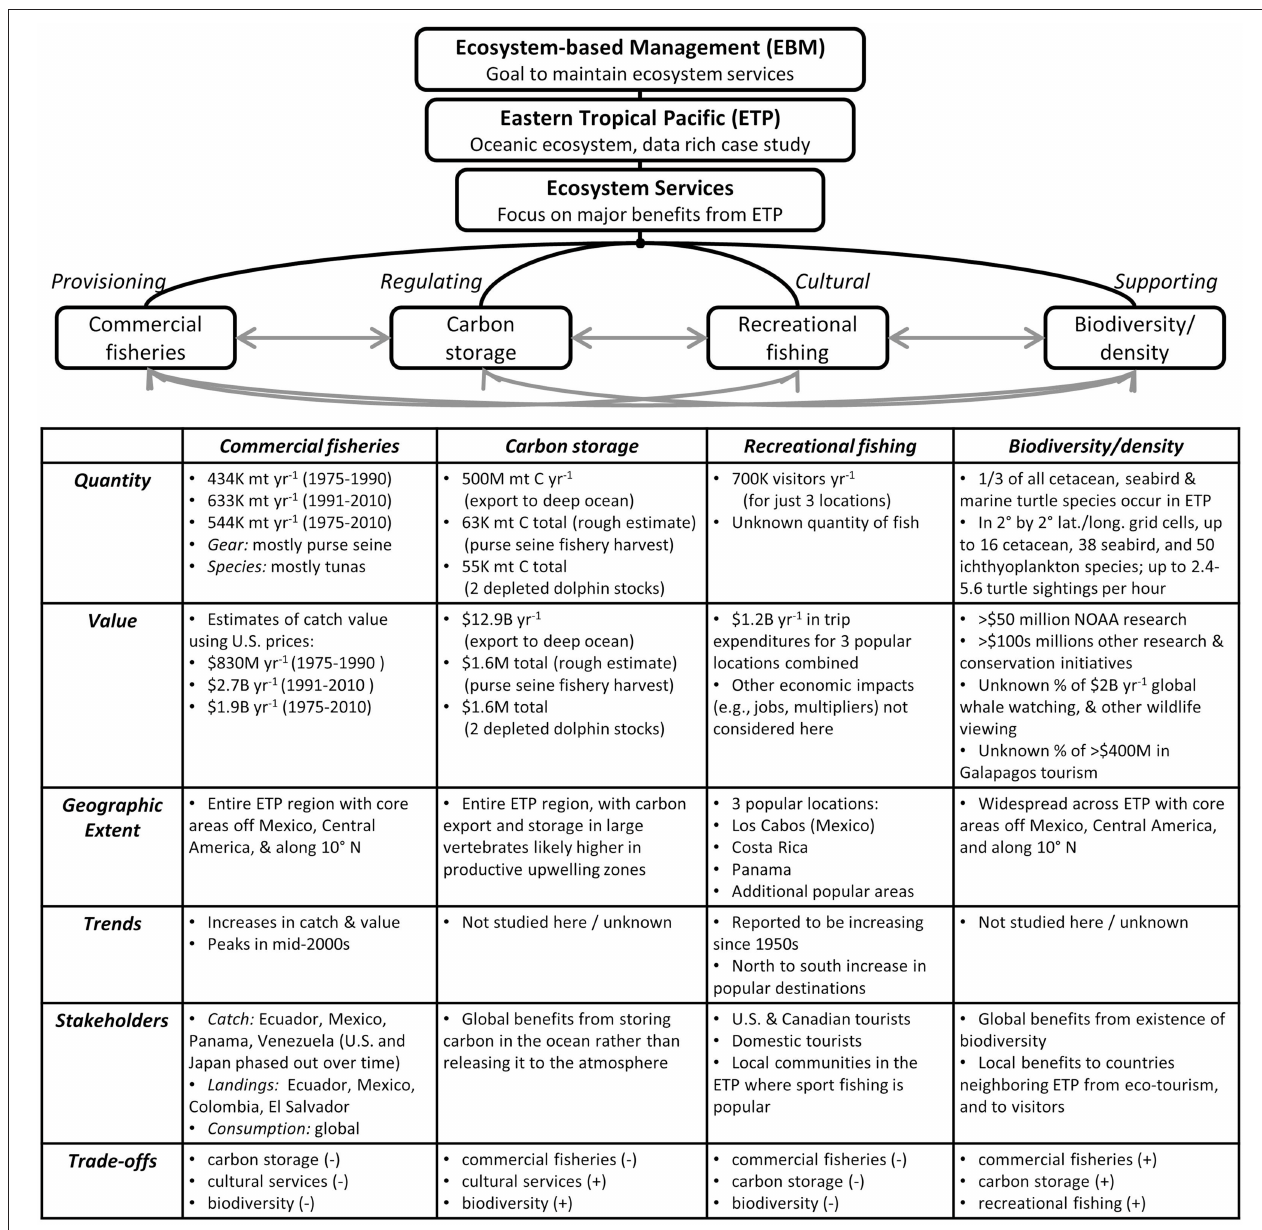
FIGURE 6 | Overview of research and summary of key findings, which provide an ecosystem services perspective for the oceanic eastern tropical Pacific (ETP). Characterization of four major ecosystem services included investigations into six characteristics of each service. The degree of insight gained for each characteristic depended on the amount of data available for analysis. For quantities and monetary values, K, thousand; M, million; B, billion. Hypothesized trade-offs between services are indicated as positive ( + , increases in one service would lead to increases in another service), or negative ( − , increases in one service would lead to decreases in another